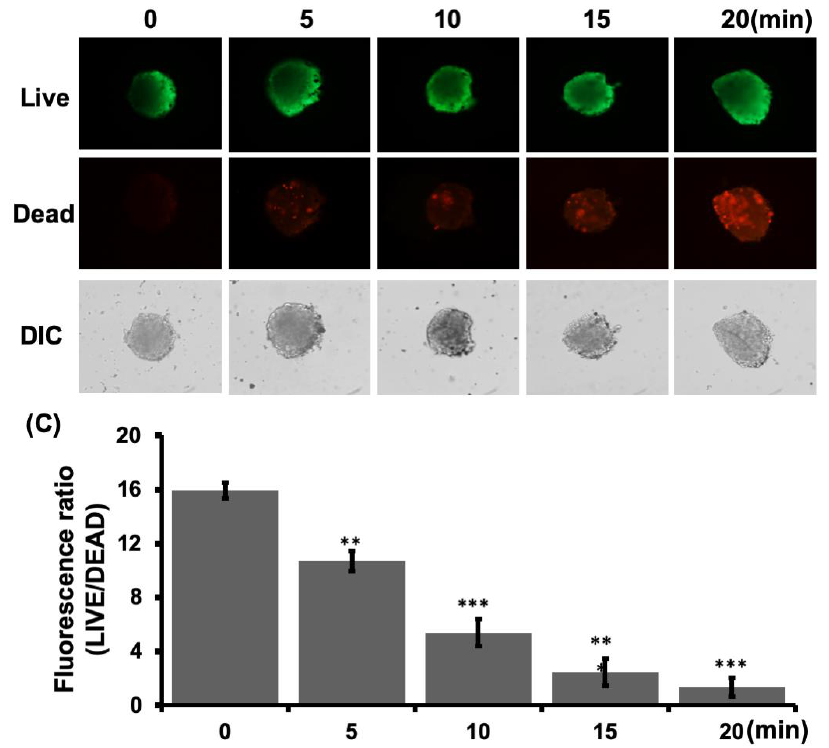
Figure 7. Photothermal treatment through bound ConA-SCHSs. ( A ) Live cell staining of MCAs showing increased red fluorescence of dead cells after photothermal treatment. ( B ) Evaluation of the relative fluorescence exhibiting the ratio of live to dead cells after staining cells in control and treated conditions.